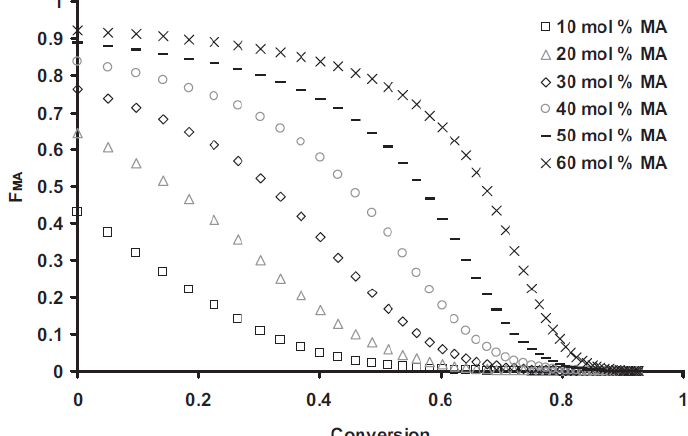
Figure 2. Instantaneous copolymer composition as a function of conversion for copolymerizations of methyl acrylate (MA) (r with permission from reference